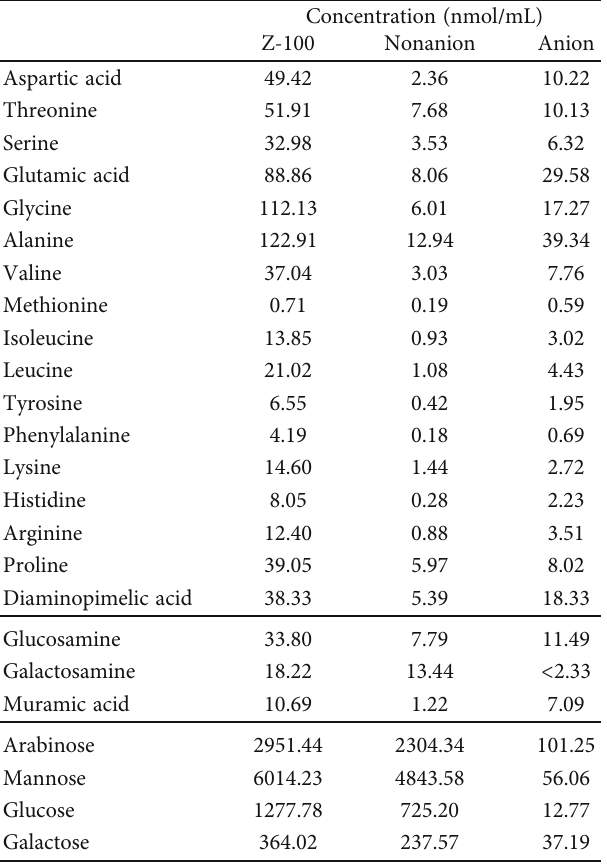
Table 1: Concentration of amino acids, amino sugars, and neutral sugars in Z-100 and nonanion and anion